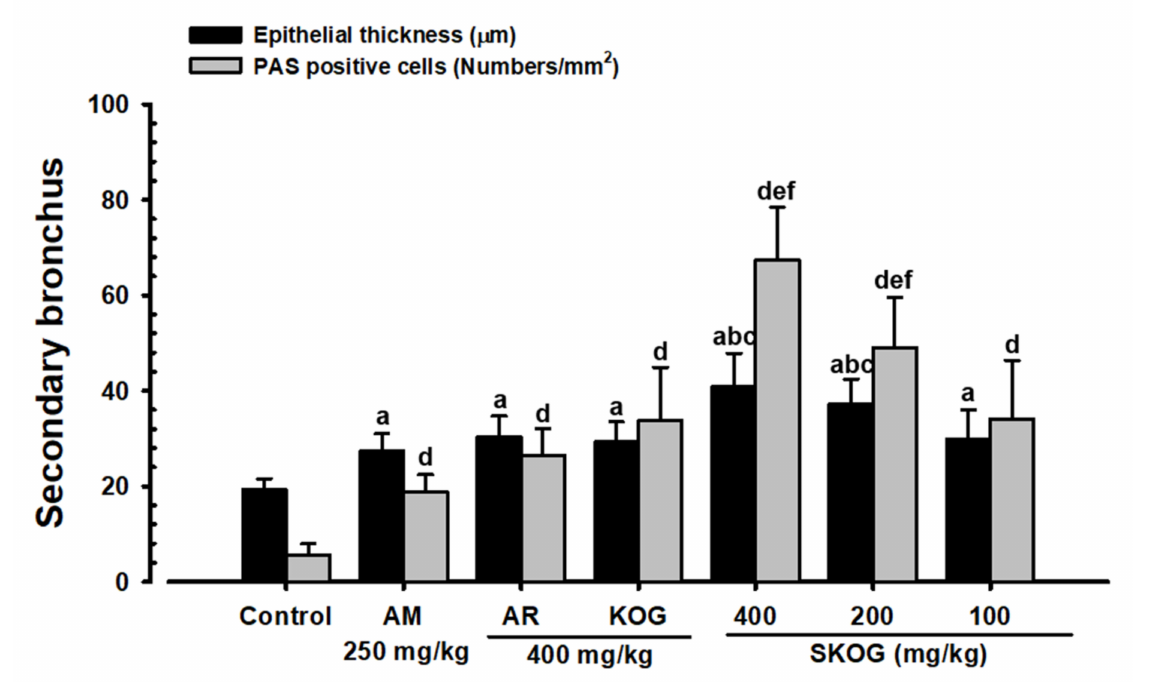
Figure 6. Effects of AR, KOG, and SKOG on the intrapulmonary secondary bronchus epithelial thicknesses and PAS-positive mucous producing cell numbers in mice. Values are presented as the mean ± SD of 10 mice. Different letters indicate statistical significance. Treatment groups expressed as a p < 0.01 and d p < 0.01, b p < 0.01 and e p < 0.01, and c p < 0.01 and f p < 0.01 compared with the intact vehicle control, AR 400 mg/kg, and KOG 400 mg/kg by the LSD and MW tests,